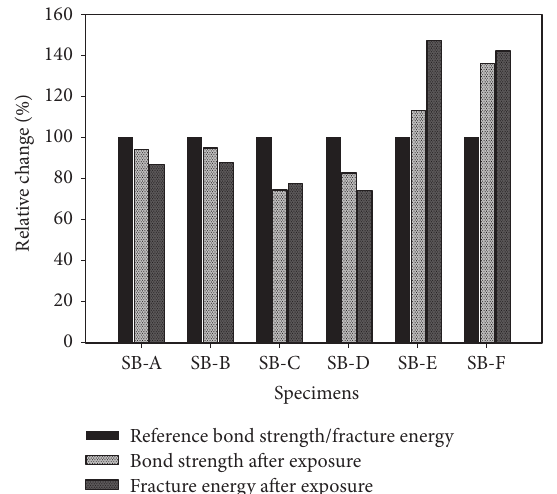
Table 3: Calculated values for 𝐵 Env . 𝑡 and 𝐺 𝑓 Env .